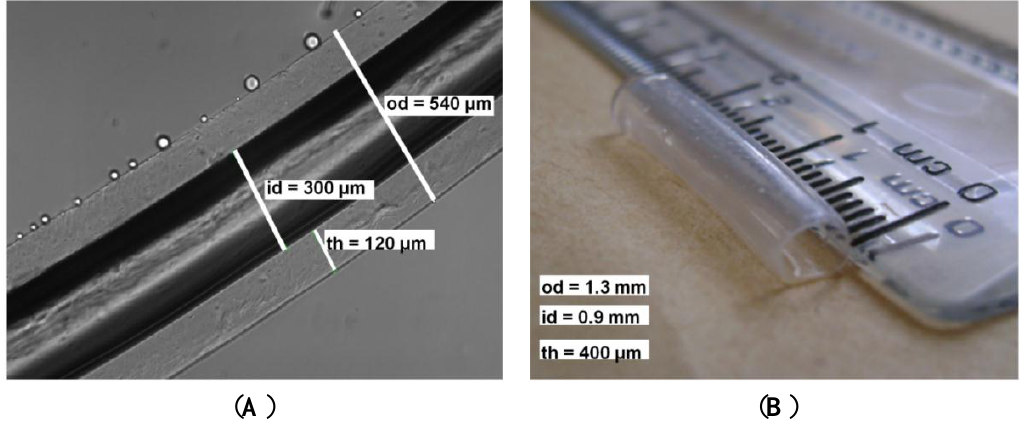
Figure 1. Hollow alginate microfiber fabricated with a metallic rod with a diameter of ( A ) 300 µm and ( B ) 0.9 mm. Figure 1A reproduced with permission from